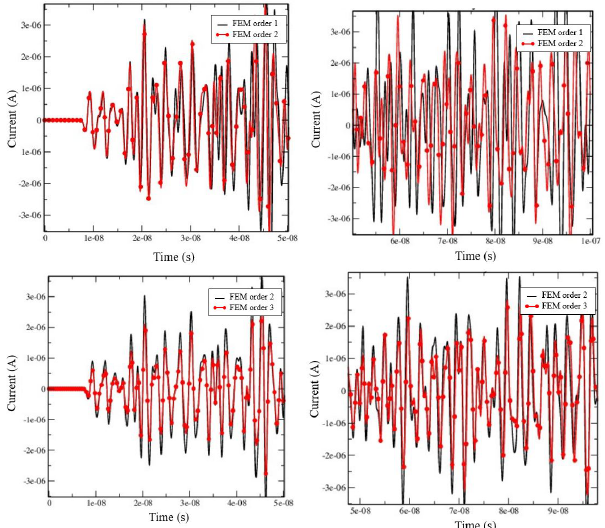
FIGURE 10: Influence of the FEM spatial order on the precision of the solution. Left [0 , 5 e − 08 s ] , right [5 e − 8 s, 10 e − 8 s ] .